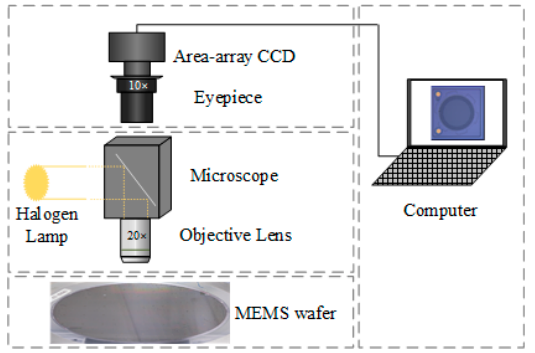
Figure 1. Data acquisition system.